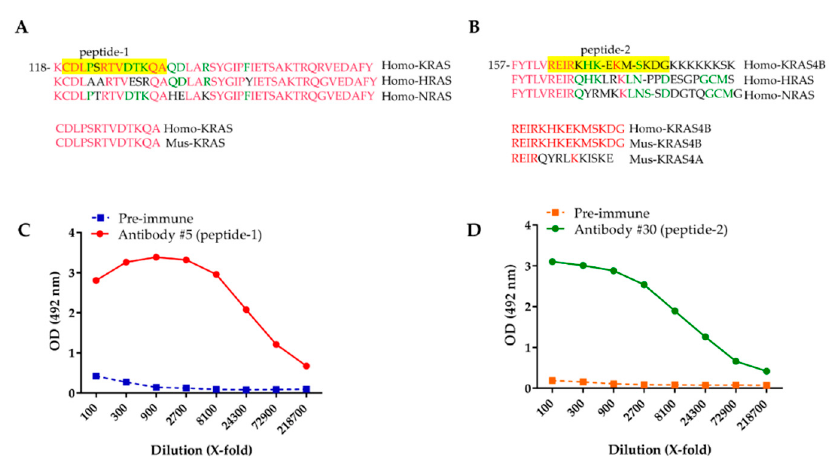
Figure 1. Generation of KRAS antibodies. ( A , B ) Partial sequence comparison between RAS family members. The peptide sequences (peptide-1 and peptide-2) used to immunize rabbits are highlighted in yellow. Peptide-1 and peptide-2 sequences are identical between human (Homo) and mouse (Mus) KRAS. Identical amino acids between all isoforms are in red. Identical amino acids between two isoforms are in green. Amino acids specific to one isoform are in black. The coordinate of the first amino acid of each sequence fragment is indicated. ( C , D ) ELISA with pre-immune sera, antibody #5, and antibody #30 on wells coated with peptide-1 and peptide-2, respectively.